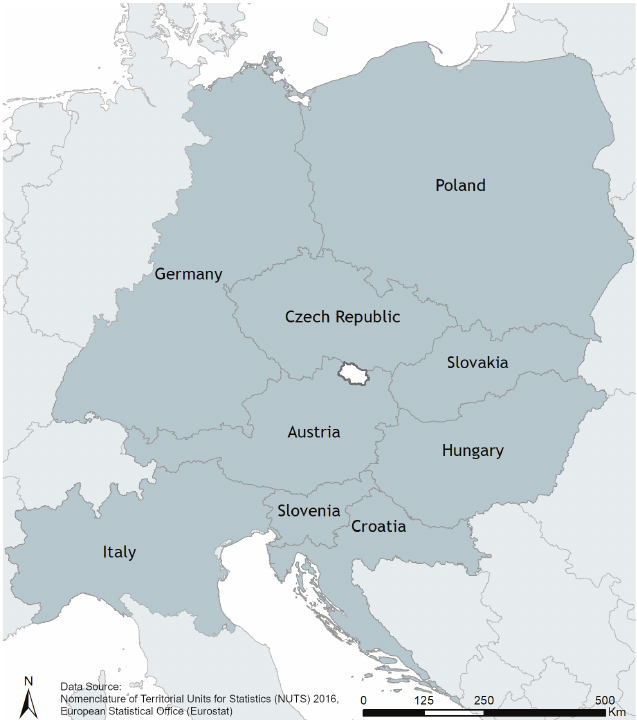
Figure 1. Location of the Austrian case study area within the Interreg Central Europe Programme